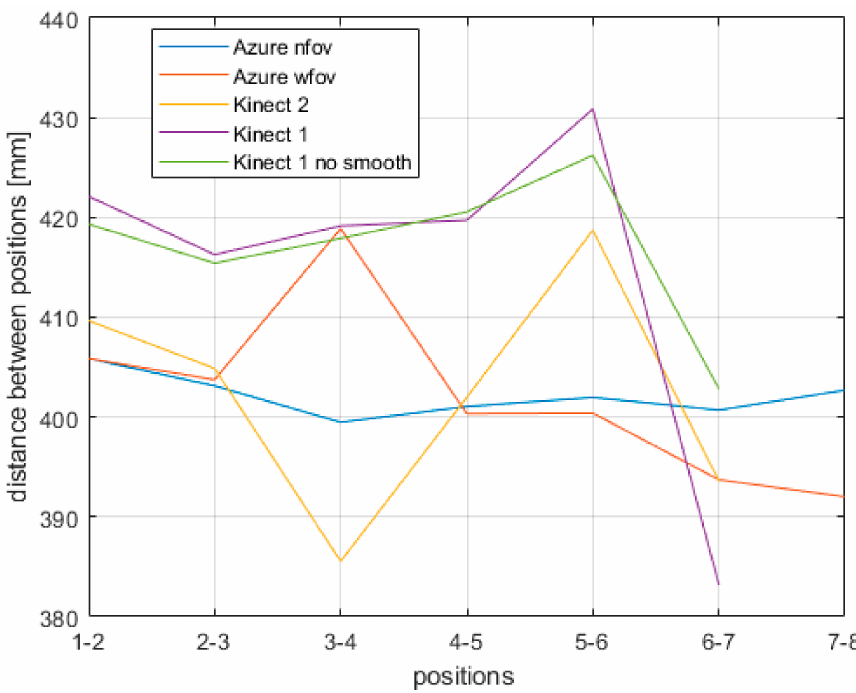
Figure 18. Body joint average position distance variation of all sensors (only body joints common for all sensors were are